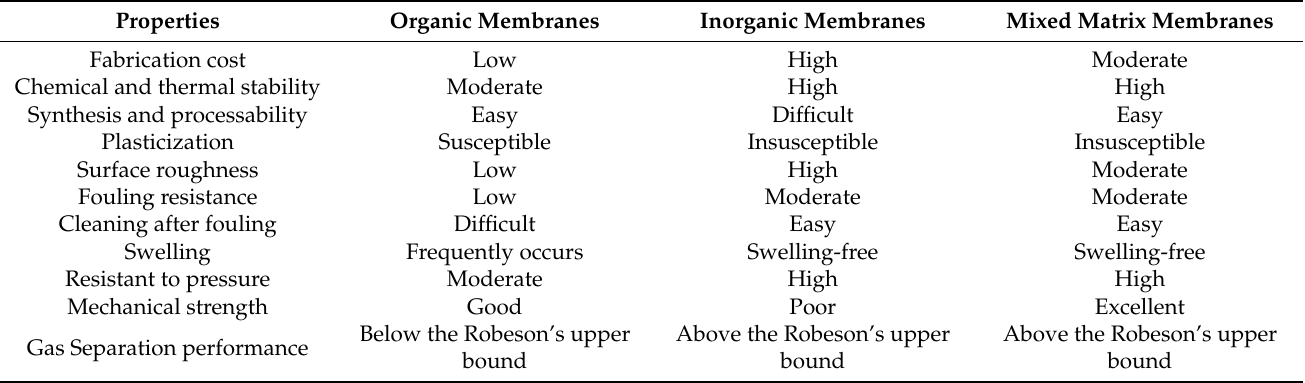
Table 2. Comparison of different characteristics of organic, inorganic, and mixed matrix membranes